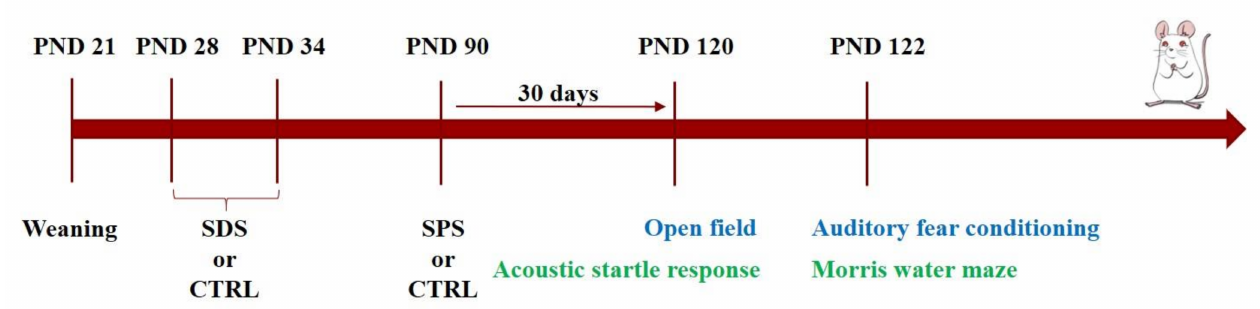
Figure 1. Experimental timeline. Separate cohorts of male rats at PND 28 were randomly assigned to either the CTRL- CTRL, SDS-CTRL, CTRL-SPS, or SDS-SPS groups. Rats were subjected to 30 min social defeat stress (SDS) daily for seven consecutive days from postnatal day (PND) 28 to 34, and then to the single prolonged stress (SPS) paradigm in adulthood (PND 90). Thirty days after SPS exposure, two separate groups of rats were exposed to a behavioral test battery. The first group was exposed to open field (PND 120) and auditory fear conditioning (PND 122) tasks, and the second one was exposed to acoustic startle response (PND 120) and Morris water maze (PND 122) tasks. One week after the last behavioral task, rats were killed, and the bilateral hippocampus was immediately dissected from each animal for biochemical